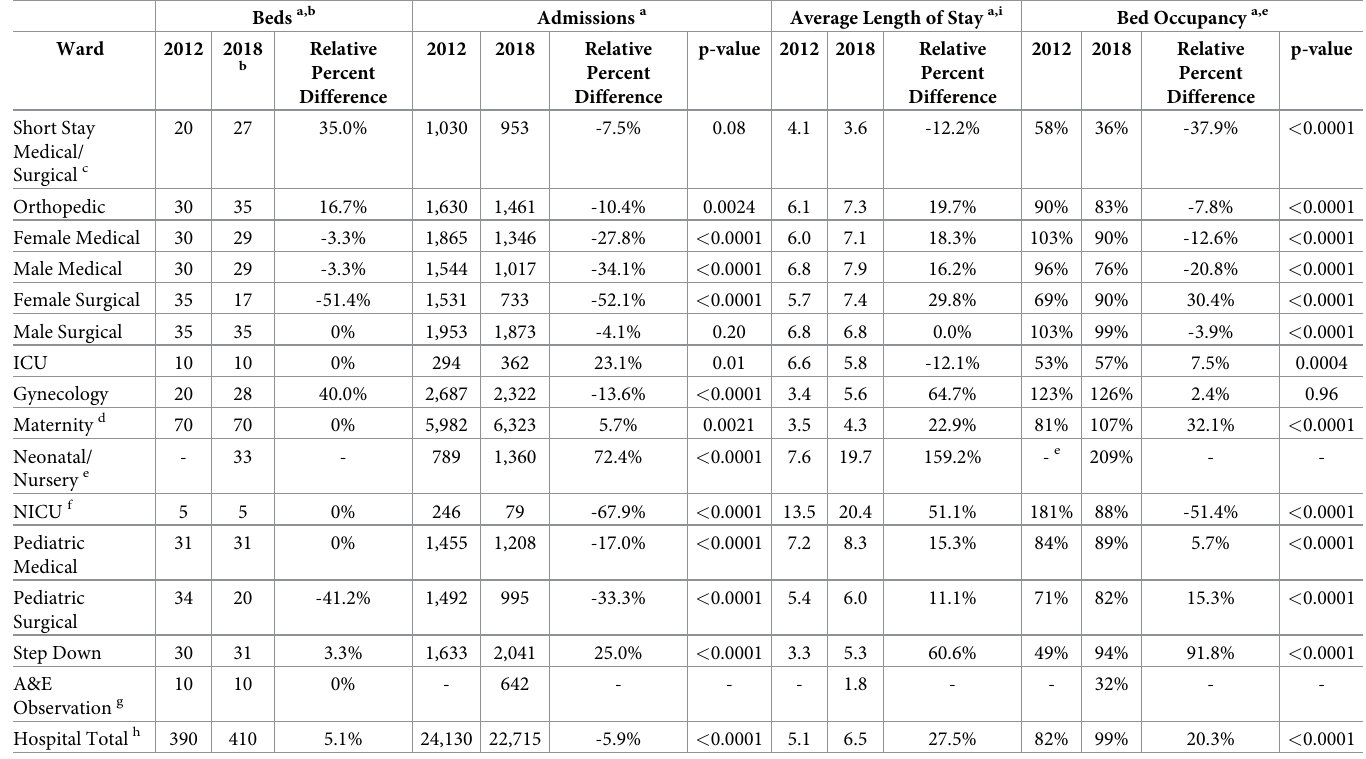
Table 2. Ward-level Utilization Measures at Queen ‘Mamohato Memorial Hospital Integrated Network Managed by a Public-Private Partnership in 2012 and 2018. Beds